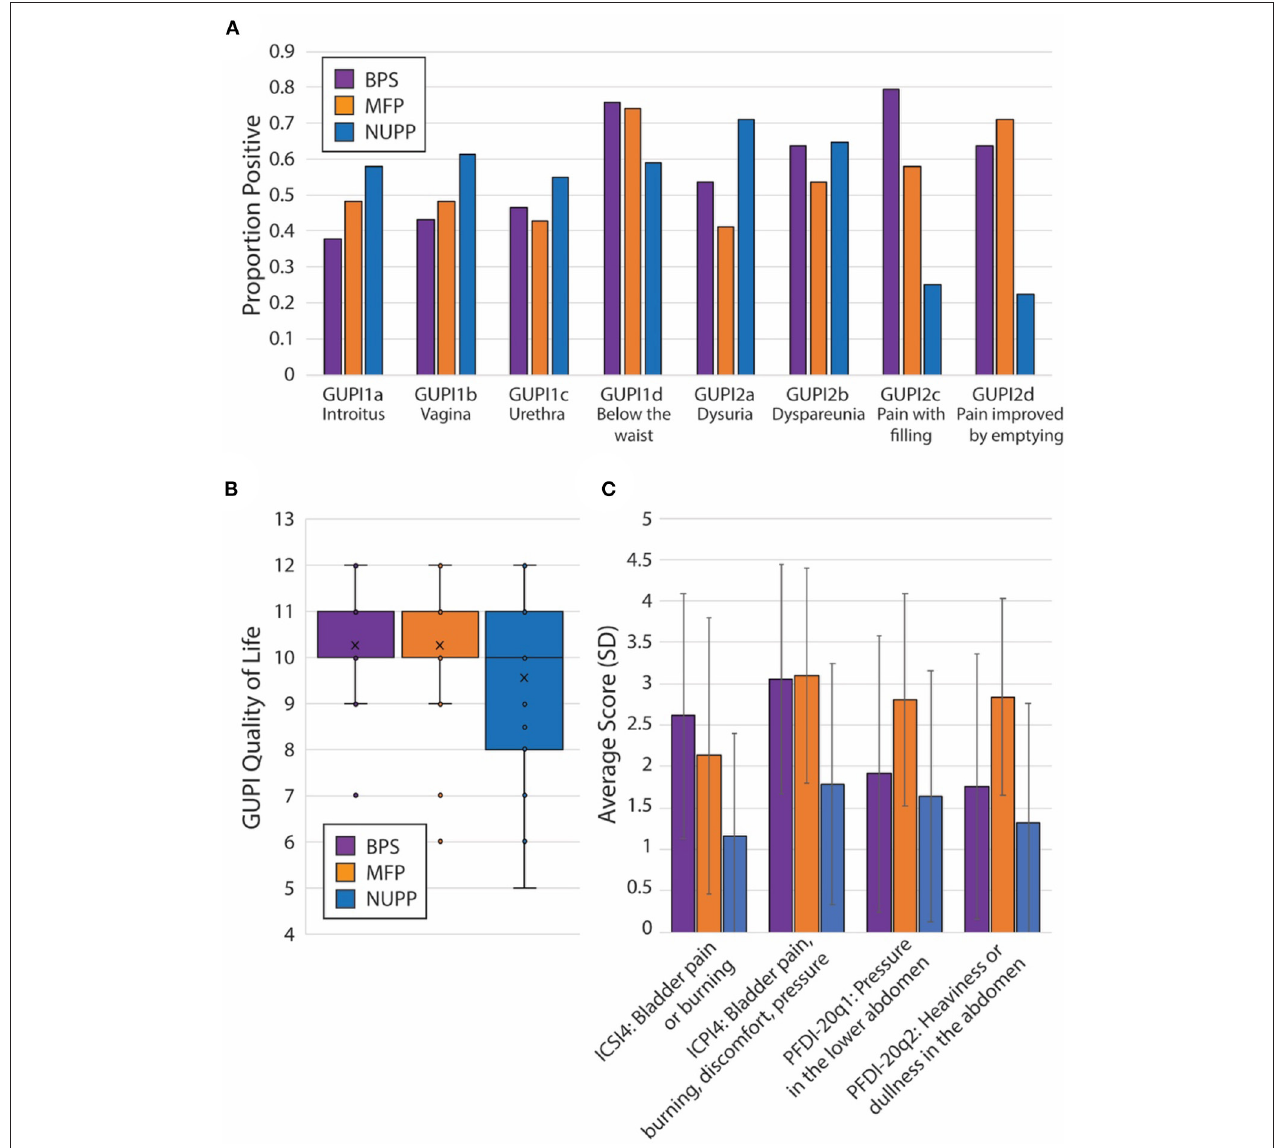
FIGURE 3 | Unique features of each IC/BPS phentoypic cluster. (A) Individual proportions of IC/BPS subjects endorsing pain symptoms by location (fGUPI1) and activity (fGUPI2) by phenotype. (B) Box and whisker plot displaying the composite quality of life score on the fGUPI for each phenotype in the inset legend. (C) Mean scores for four independent measures of bladder-related pain, pressure or discomfort are shown by phenotypic group. Error bars display the standard deviations. Significances for all pairwise comparisons are listed in Table 2